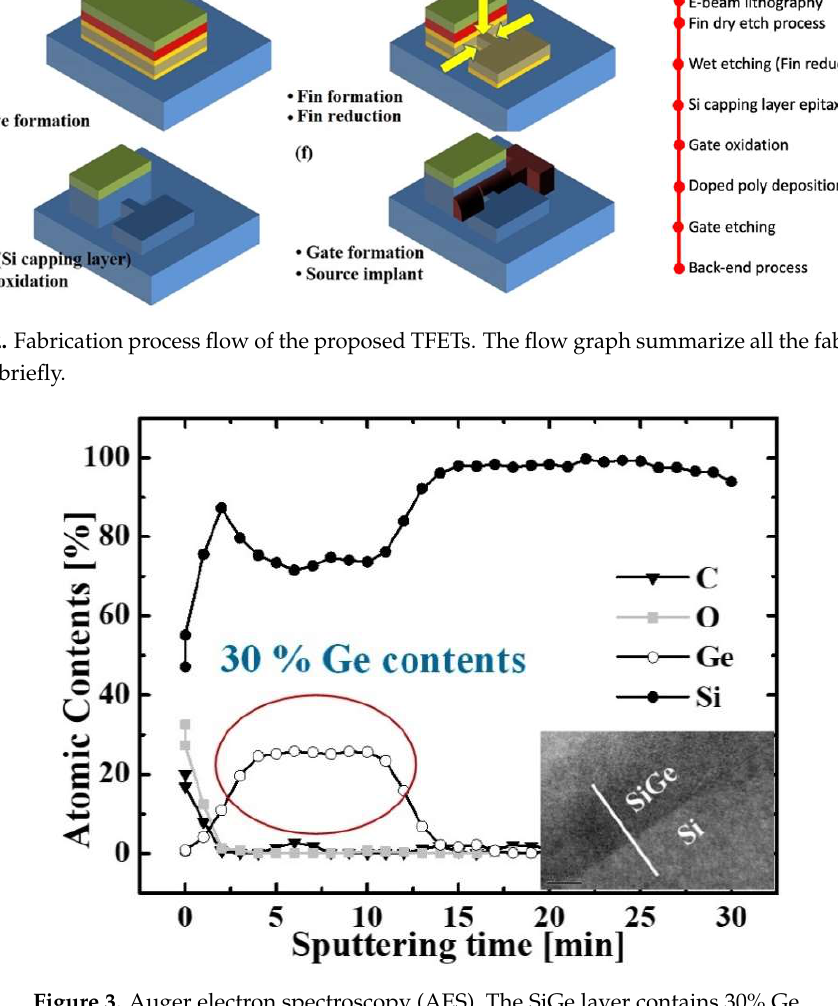
Figure 3. Auger electron spectroscopy (AES). The SiGe layer contains 30% Ge.